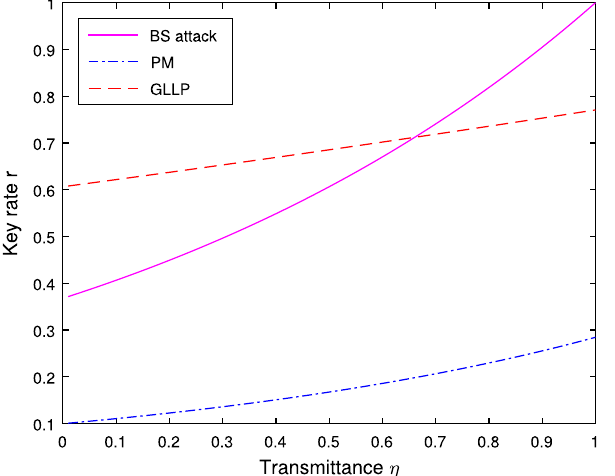
FIG. 9. Key-rate comparison with fixed transmittance η ¼ 0 . 2 . The GLLP tagging formula for the single-photon component cannot hold under the beam-splitting